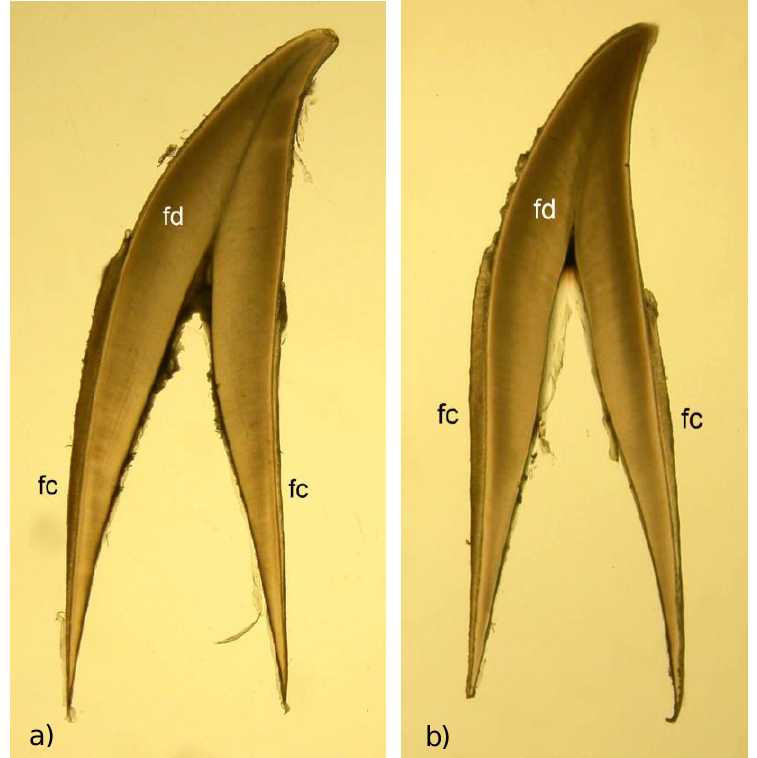
Fig. 3. First-formed growth layers in a beluga tooth. (a) HI-08-06 fetus, MNR-3; (b) neonate AREP86-14, MNR-5. Both teeth have fetal dentine (fd) and thin fetal cementum (fc). No postnatal growth layers have been deposited in (b). The fetal cementum on the anterior surface (left side of section) is slightly thicker and higher on the cusp compared to the posterior